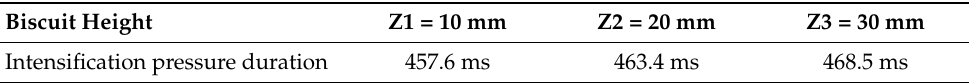
Table 5. Duration period of holding pressure action and its dependence on biscuit height. Biscuit